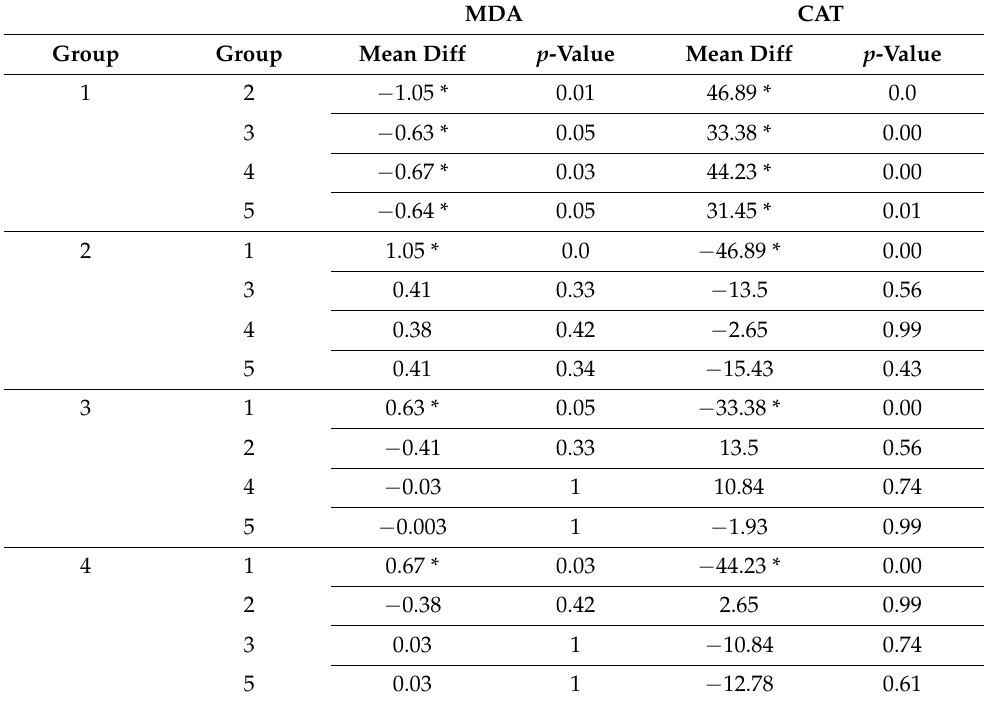
Table 5. Scheffe’s test results for multiple